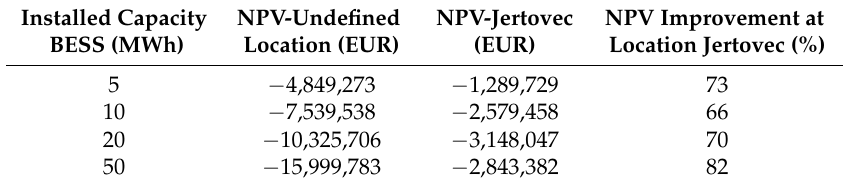
Table 4. NPV indicators for 25% reduced BESS investment cost: undefined location and location Jertovec.